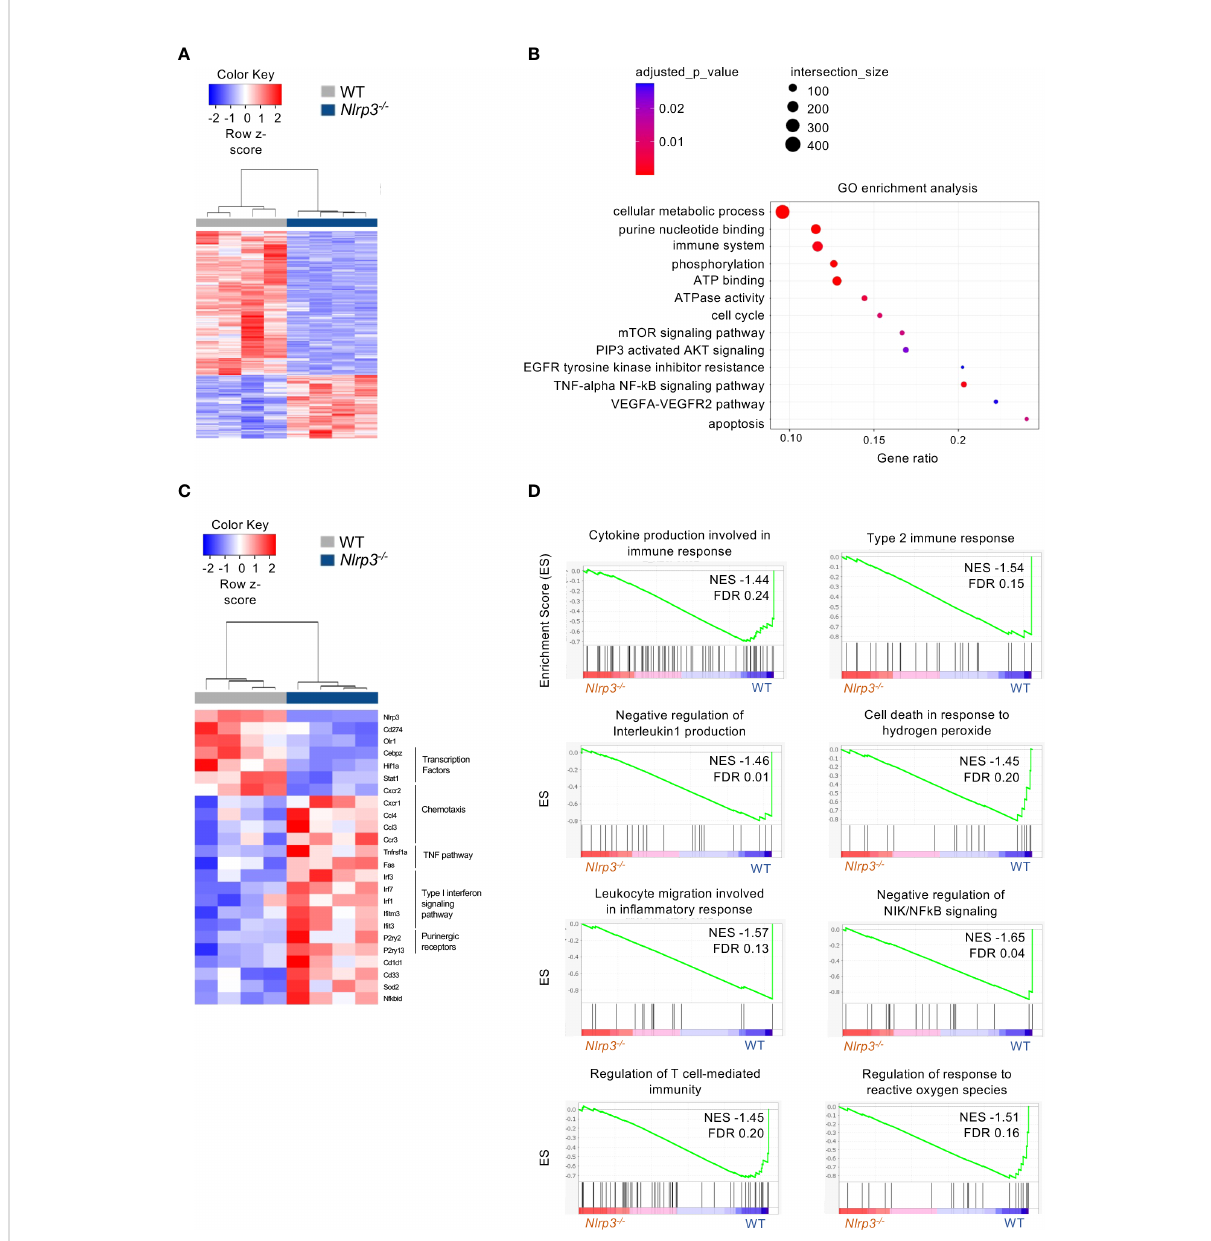
FIGURE 6 NLRP3 de fi ciency induces a transcriptional re-wiring to G-MDSCs. (A) Heatmap of DEGs from G-MDSCs from tumor-bearing Nlrp3 -/- ( n = 4) and WT ( n = 4) mice. (B) Pathway analysis of DEGs from Nlrp3 -/- vs. WT. (C) Heatmap of selected DEGs from G-MDSCs from tumor-bearing Nlrp3 -/- and WT mice. (D) GSEA plot showing the enrichment of “ Cytokine production involved in immune response" (NES − 1.44, FDR 0.24), “ Type 2 immune response ” (NES − 1.54, FDR 0.15), “ Negative regulation of interleukin 1 production ” (NES − 1.46, FDR 0.01), “ Cell death in response to hydrogen peroxide ” (NES − 1.45, FDR 0.20), “ Leukocyte migration involved in in fl ammatory response ” (NES − 1.57, FDR 0.13), “ Negative regulation of NIK/NFkB signaling ” (NES − 1.65, FDR 0.04), “ Regulation of T cell-mediated immunity ” (NES − 1.45, FDR 0.20), and “ Regulation of response to reactive oxygen species ” (NES − 1.51, FDR 0.16) gene